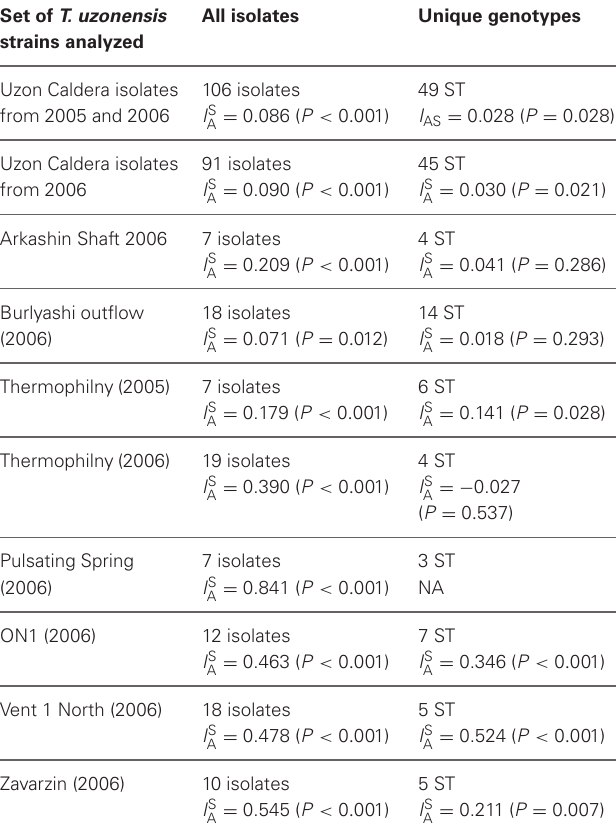
Table 8 | Standardized index of association values calculated with the T. uzonensis MLSA